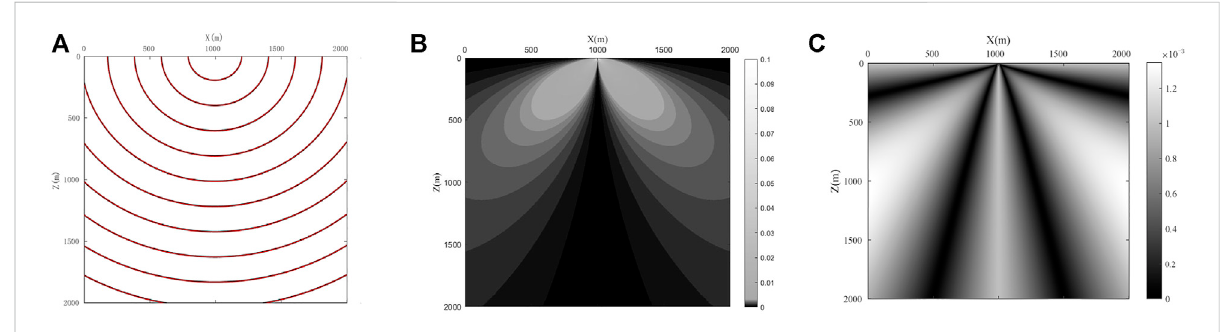
FIGURE 3 Schematic diagram of trial calculation results for homogeneous media, (A) Schematic diagram of FIM travel time contour (calculated value of red line, theoretical value of black line); (B) schematic diagram of relative error of FMM; (C) schematic diagram of absolute error of GMM.